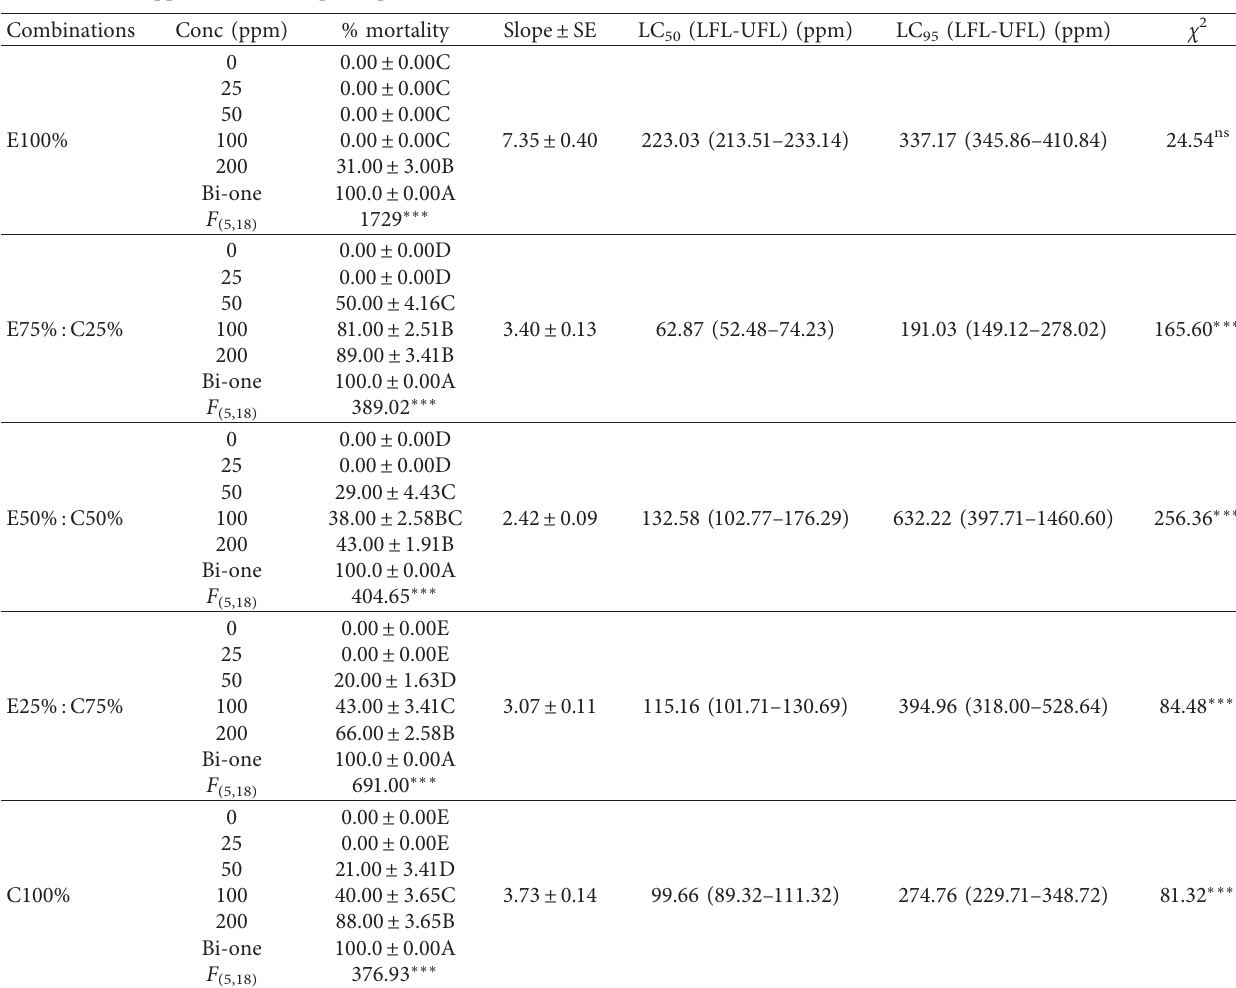
Table 5: Mortality percent of A. gambiae larvae treated with the combination of the essential oils of E. camaldulensis and C. rigidus and LC as well as LC 95 (ppm) values 24 h postexposure.